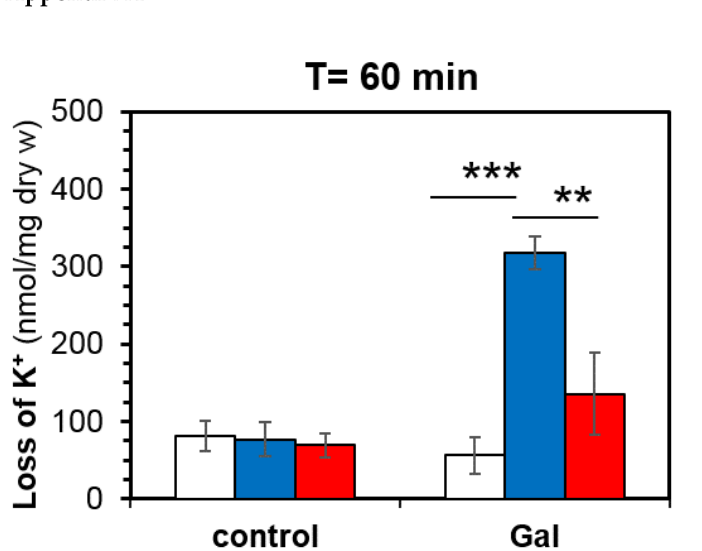
Figure A1. Amount of K + lost from cells within the first 60 min of the experiment shown in Figure 2A. Strains are BY4741 (white), ZCZ01 (blue), and ZCZ06 (red). Data represent the mean ± SEM from at least four independent experiments, **, p < 0.01; ***, p < 0.001.